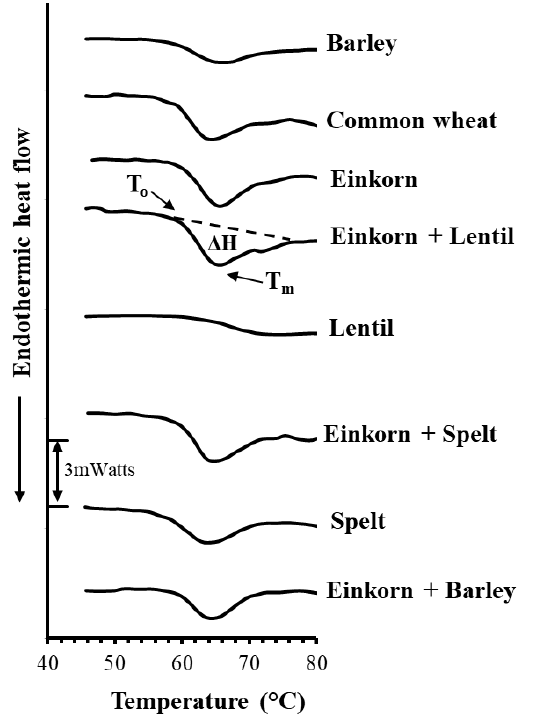
Figure 4. Representative Differential Scanning Calorimetry (DSC) thermographs of slurries (35% w / w ) of the flour samples used for breadmaking (heating rate 5 °C/min): T o , onset starch gelatiniza- tion temperature; T m , peak starch gelatinization temperature; ΔH, apparent starch gelatinization enthalpy; notation of samples as in Table 1.